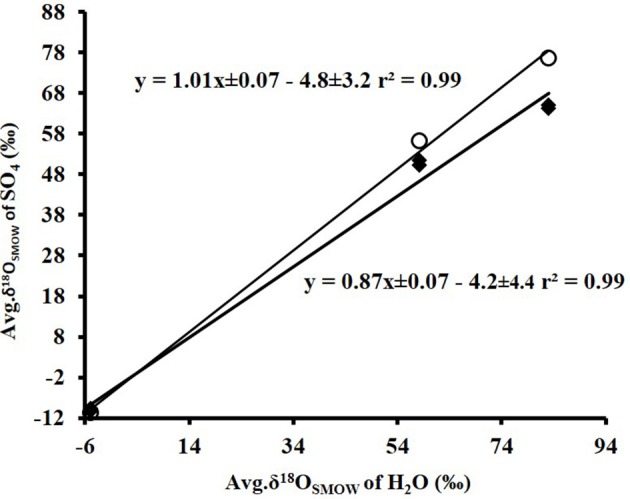
Plot of the average δ18OSO4 (n = 37)(•) produced from microbial oxidation of elemental sulfur and (◦) produced from main stage oxidation vs. average δ18OH2O (n = 3) values and used in the experiments (see Table 1).